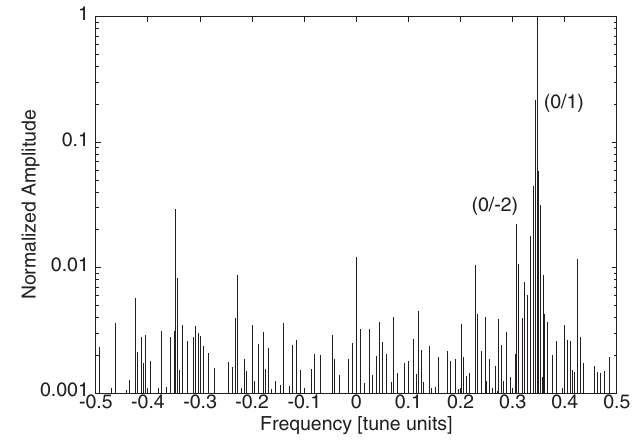
FIG. 21. Fourier spectrum without compensation.